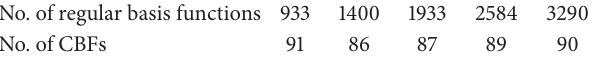
Table 1: Number of regular basis functions and resulting CBFs.